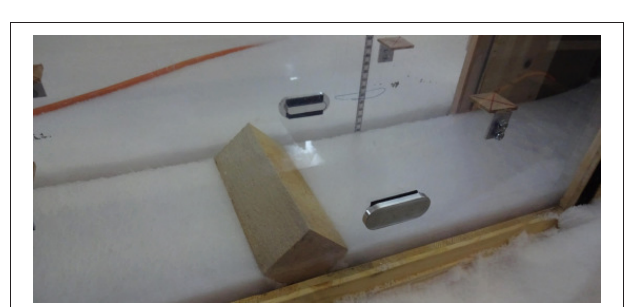
FIGURE 2 | The obstacle in the test section at the beginning of an experiment. The obstacle is a block of wood with a square 6 × 6cm cross